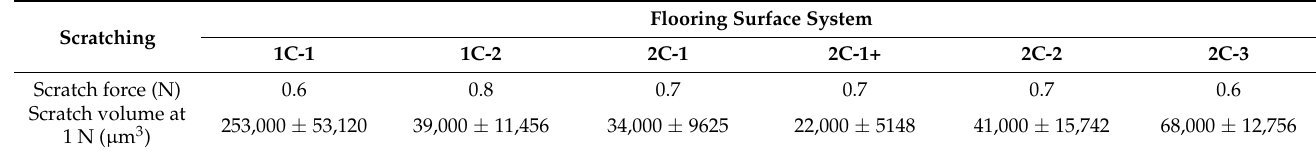
Table 5. Surface resistance to scratching.